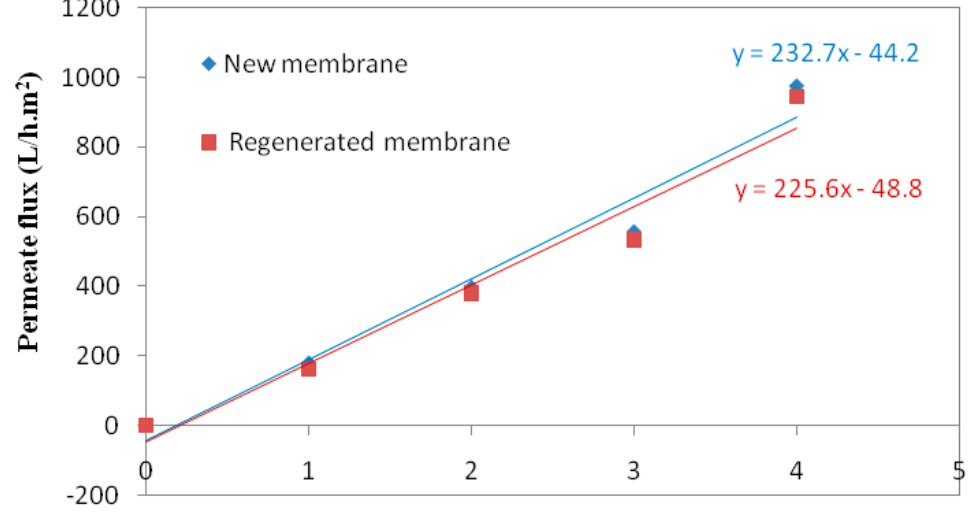
Figure 11. Water permeate flux versus transmembrane pressure for the new and regenerated mem-